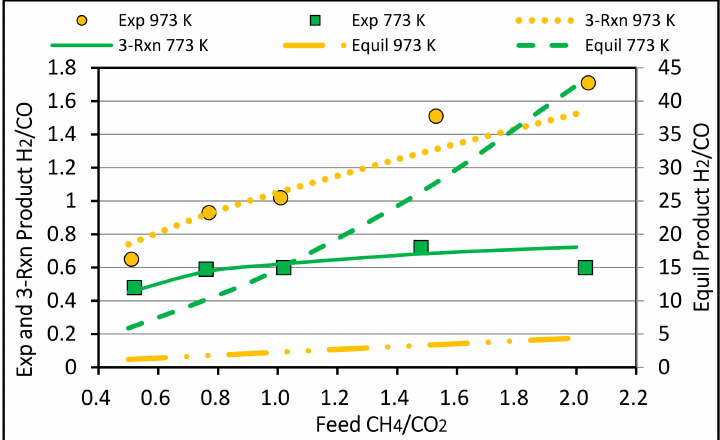
Figure 11. E ff ect of temperature, feed molar ratio on H 2 / CO at GSV = 5.56 × 10 − 4 m 3 /